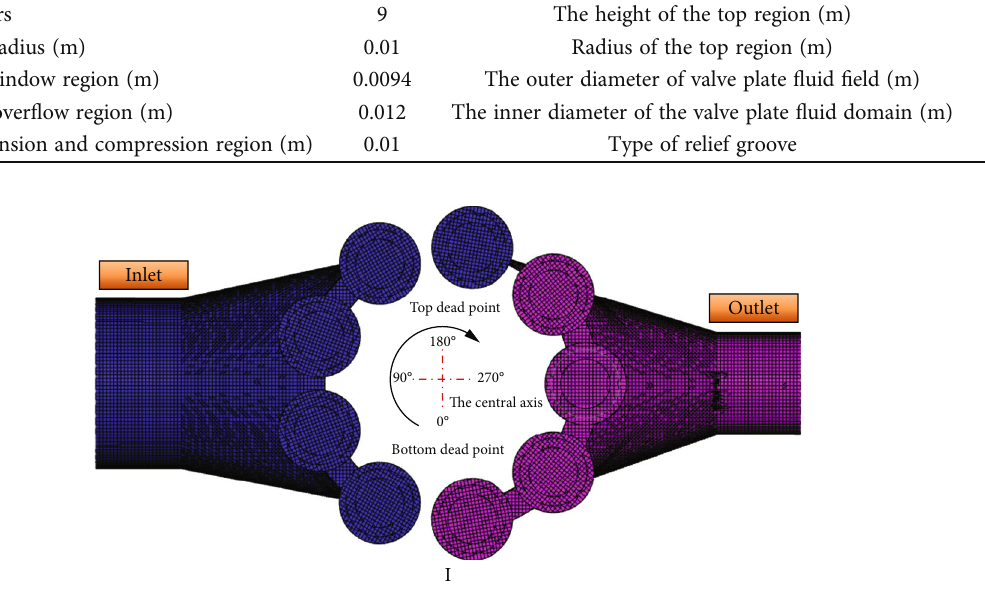
Figure 7: The fl uid domain and mesh motion diagram of the plunger chamber. Table 2: Input parameters of CFD simulation